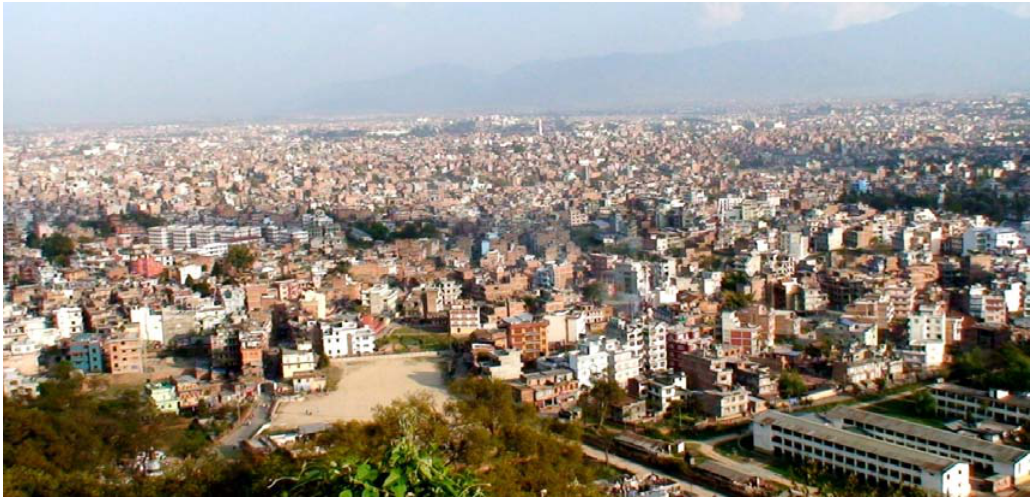
Figure 2. A perspective view of urban landscape development in Kathmandu Valley (Photo by author, fieldwork,